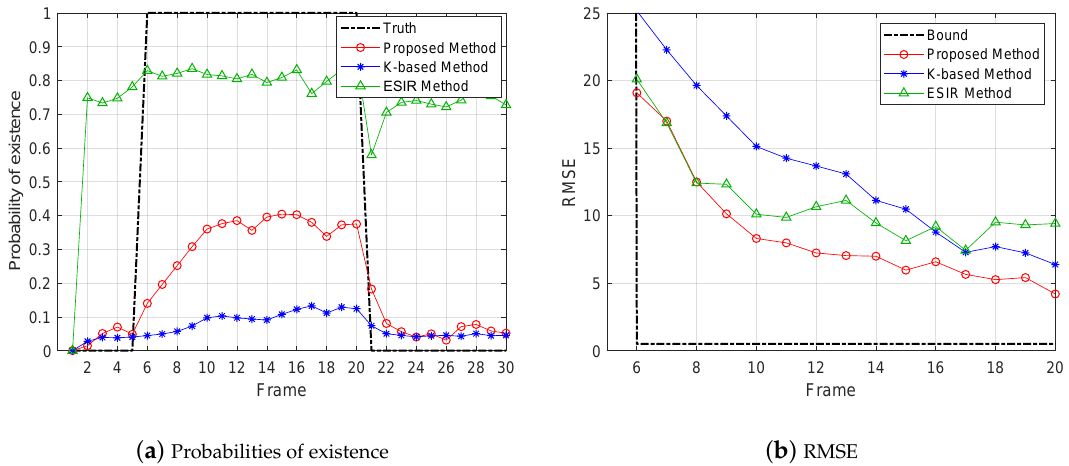
Figure 9. Probabilities of existence and Results of RMSE in case of SCR = 8 dB.